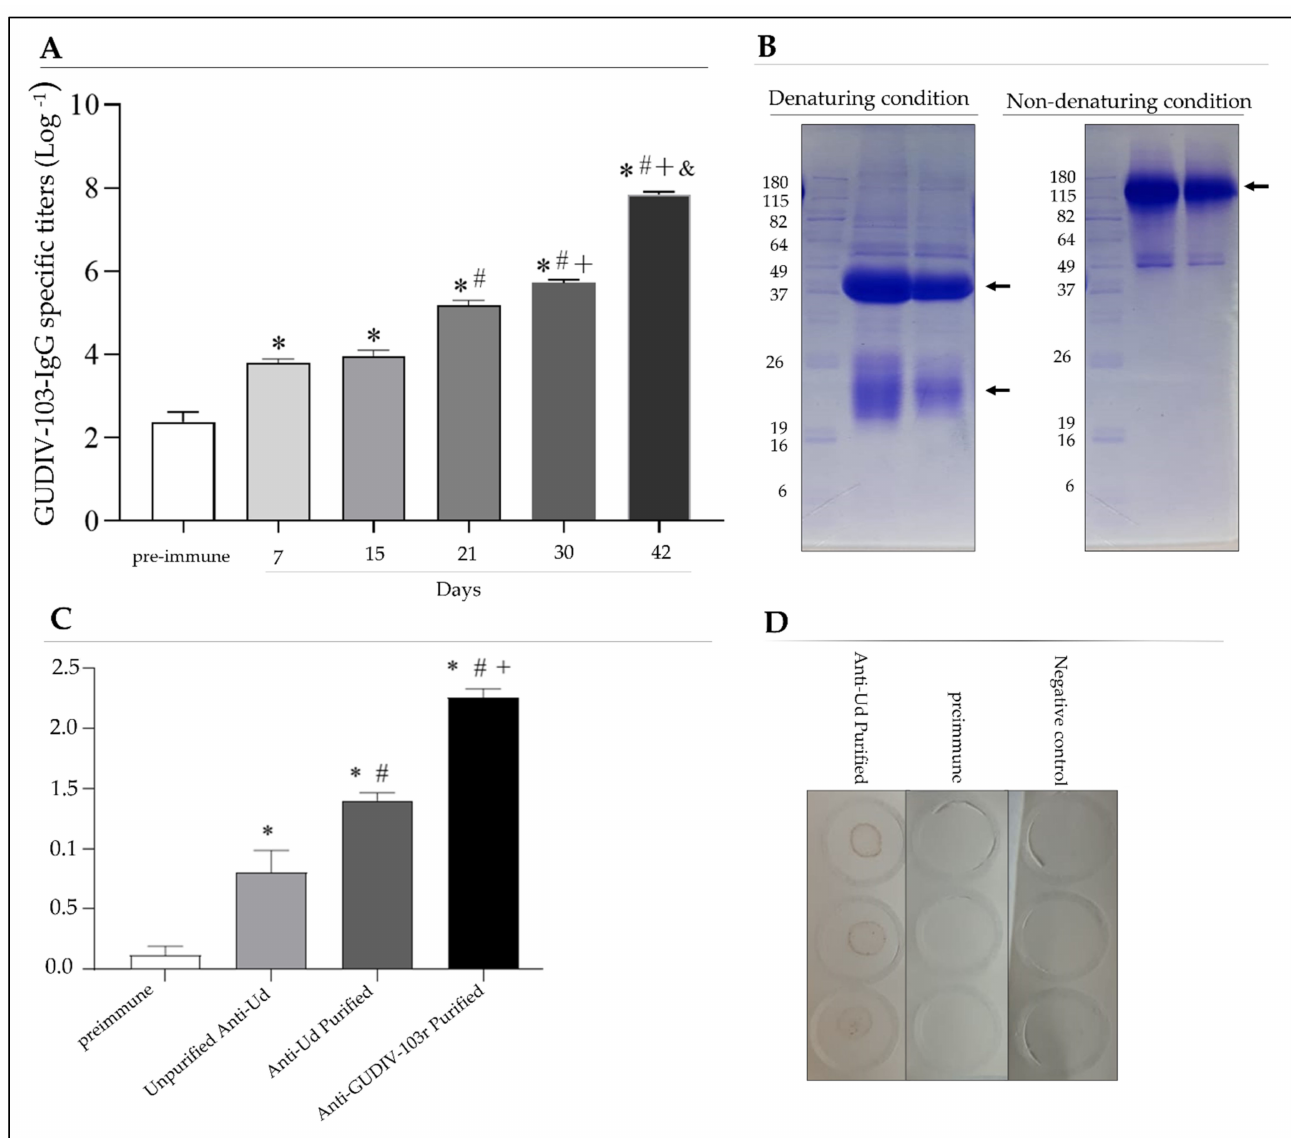
Figure 2. Immunoreactivity of anti-GUDIV-103 antibodies produced by inoculating rabbits with Ureaplasma diversum or purified recombinant GUDIV-103 (rGUDIV-103). ( A ) Specific IgG responses induced in rabbits immunised with 500 µ g rGUDIV-103 after 7 d (first dose), 15 d (second dose), 21 d (second dose), 30 d (third dose) and 42 d (third dose) or against U. diversum ATCC 49783 using blood samples collected every 7 d for 42 d. * p < 0.05 vs. preimmune group. * # p < 0.05 vs. preimmune group and 7 and 15 days groups. * #+ p < 0.05 vs. preimmune group and 7, 15 and 21 days groups. * #+& p < 0.05 vs. preimmune group and 7, 15, 21 and 30 days groups. ( B ) Electrophoretic profile (12.5% polyacrylamide gel) of specific IgG produced in rabbits after delipidation and purification by affinity chromatography in denaturing (left) and non-denaturing (right) conditions. Both gels were stained using Coomassie blue. Arrows on the left image represent the IgG heavy chain (~50 kDa) and the light chain (~25 kDa), and the arrow in the right image indicates the undenatured IgG antibody (~150 kDa). ( C ) Immunoreactivity of serum samples measured via enzyme-linked immunoassay (ELISA) at 450 nm. The following sera were used: pre-immune, impurified anti- Ud , purified anti- Ud , and purified anti-rGUDIV-103. rGUDIV-103 (200 ng/well) was used in each well. * p < 0.05 vs. preimmune group. * # p < 0.05 vs. preimmune group and unpurified anti-Ud group. * #+ p < 0.05 vs. preimmune group and unpurified anti-Ud group and anti-Ud purified group. ( D ) Dot blot of nitrocellulose membrane sensitised with rGUDIV-103 and incubated with anti-